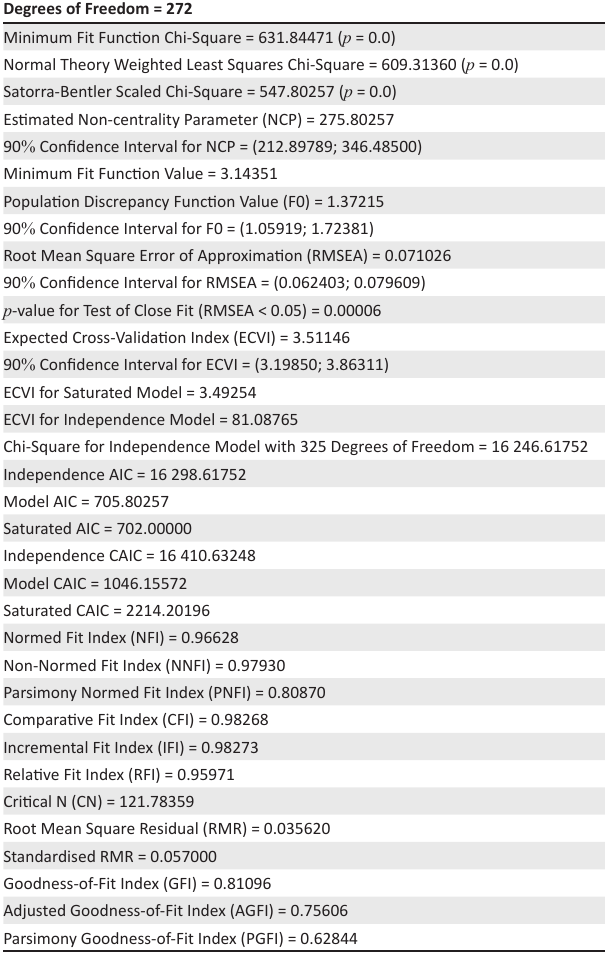
TABLE 5 : The goodness-of-fit statistics for the work-unit performance comprehensive LISREL model with paths from core people processes and climate to satisfaction were fixed to